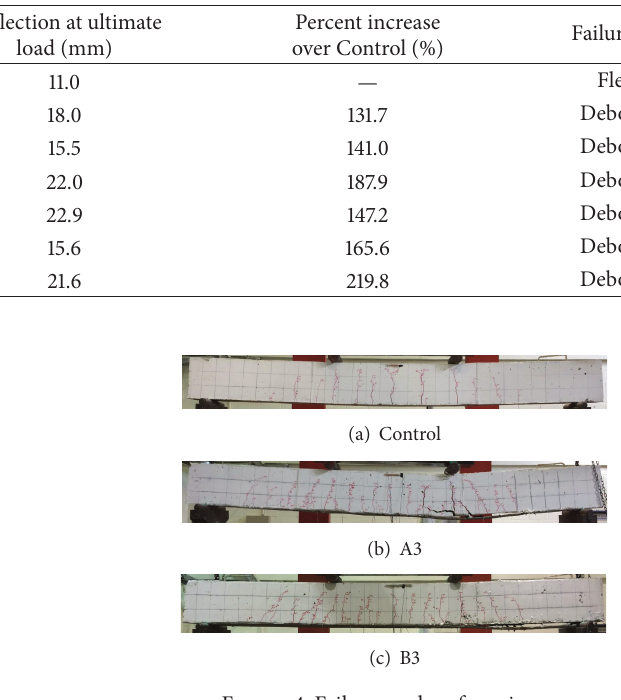
Figure 3: Test setup. Figure 4: Failure modes of